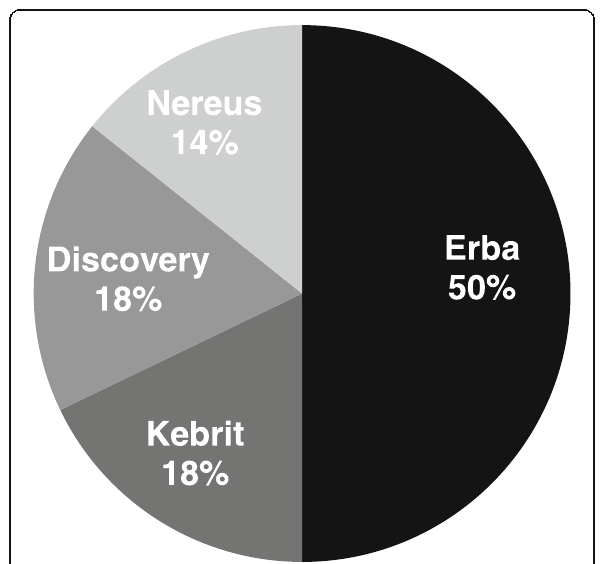
Fig. 1 The percentage of active extracts from bacterial strains isolated from the respective brine-pools. Pie chart represents the distribution of extracts based on their source in the Red Sea that induced greater than 30% growth inhibition in various cancer cell lines at a concentration of 200 μ g/ml after 24 h of